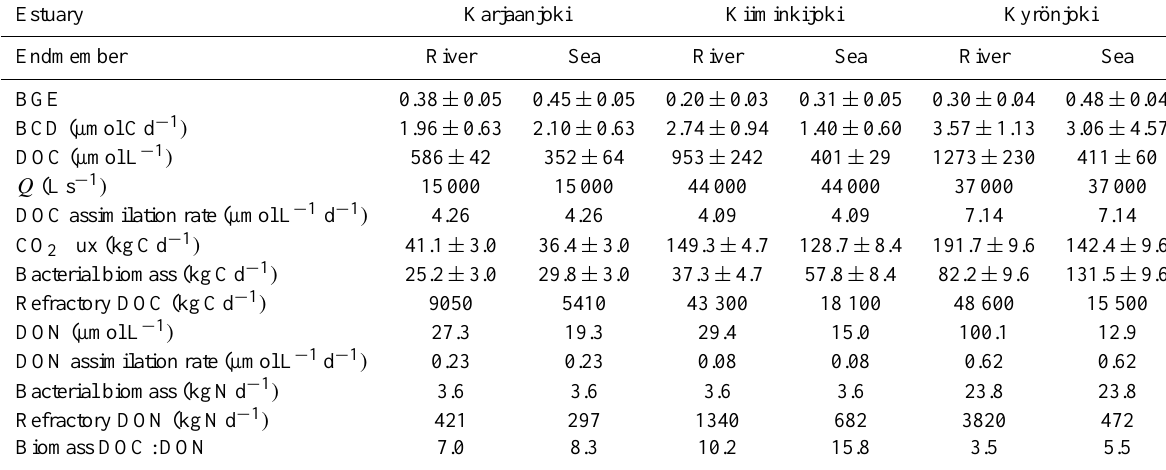
Table 4. Daily CO 2 fluxes and bacterial biomass generation from DOC and DON, and inferred biomass DOC:DON ratio in river and sea endmembers in each study estuary. Average BGE, BCD, DOC and DON concentrations, and C and N assimilation rates are derived from the results of this study. The range given in BGE values originates from different cell carbon content assumptions (30.2 ± 12.3fgCcell − 1 ; Fukuda et al., 1998). With BCD and DOC values also a standard deviation of the averaged data set is given. Q data is averaged over the whole study period from the SYKE HERTTA database (HERTTA, 2012). Water volume in sea endmember is equivalent to the river endmembers daily discharge for enabling direct comparison of these two. Range given in CO 2 flux and bacterial biomass originates from different cell carbon coefficients. Refractory DOC and DON are the amounts not assimilated to bacterial biomass or respired (only